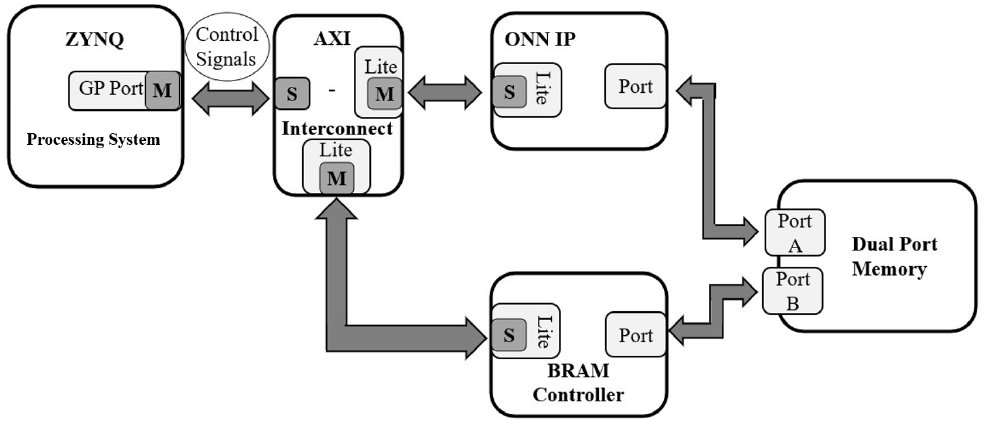
Figure 5. The proposed system design using